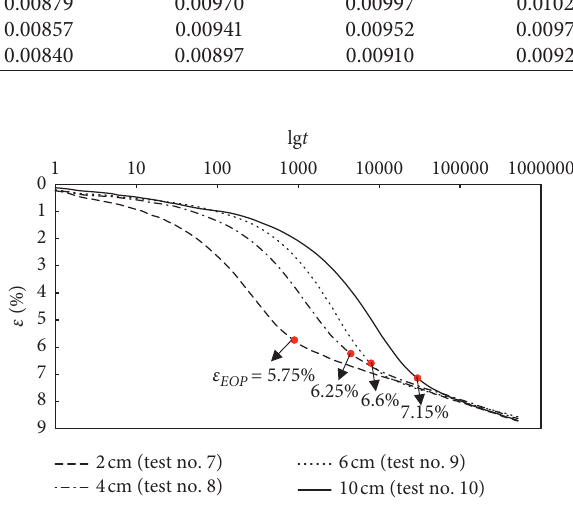
Figure 10: ε − lg t curves for soil samples with different thicknesses under the step loading of 100kPa of the oedometer tests.